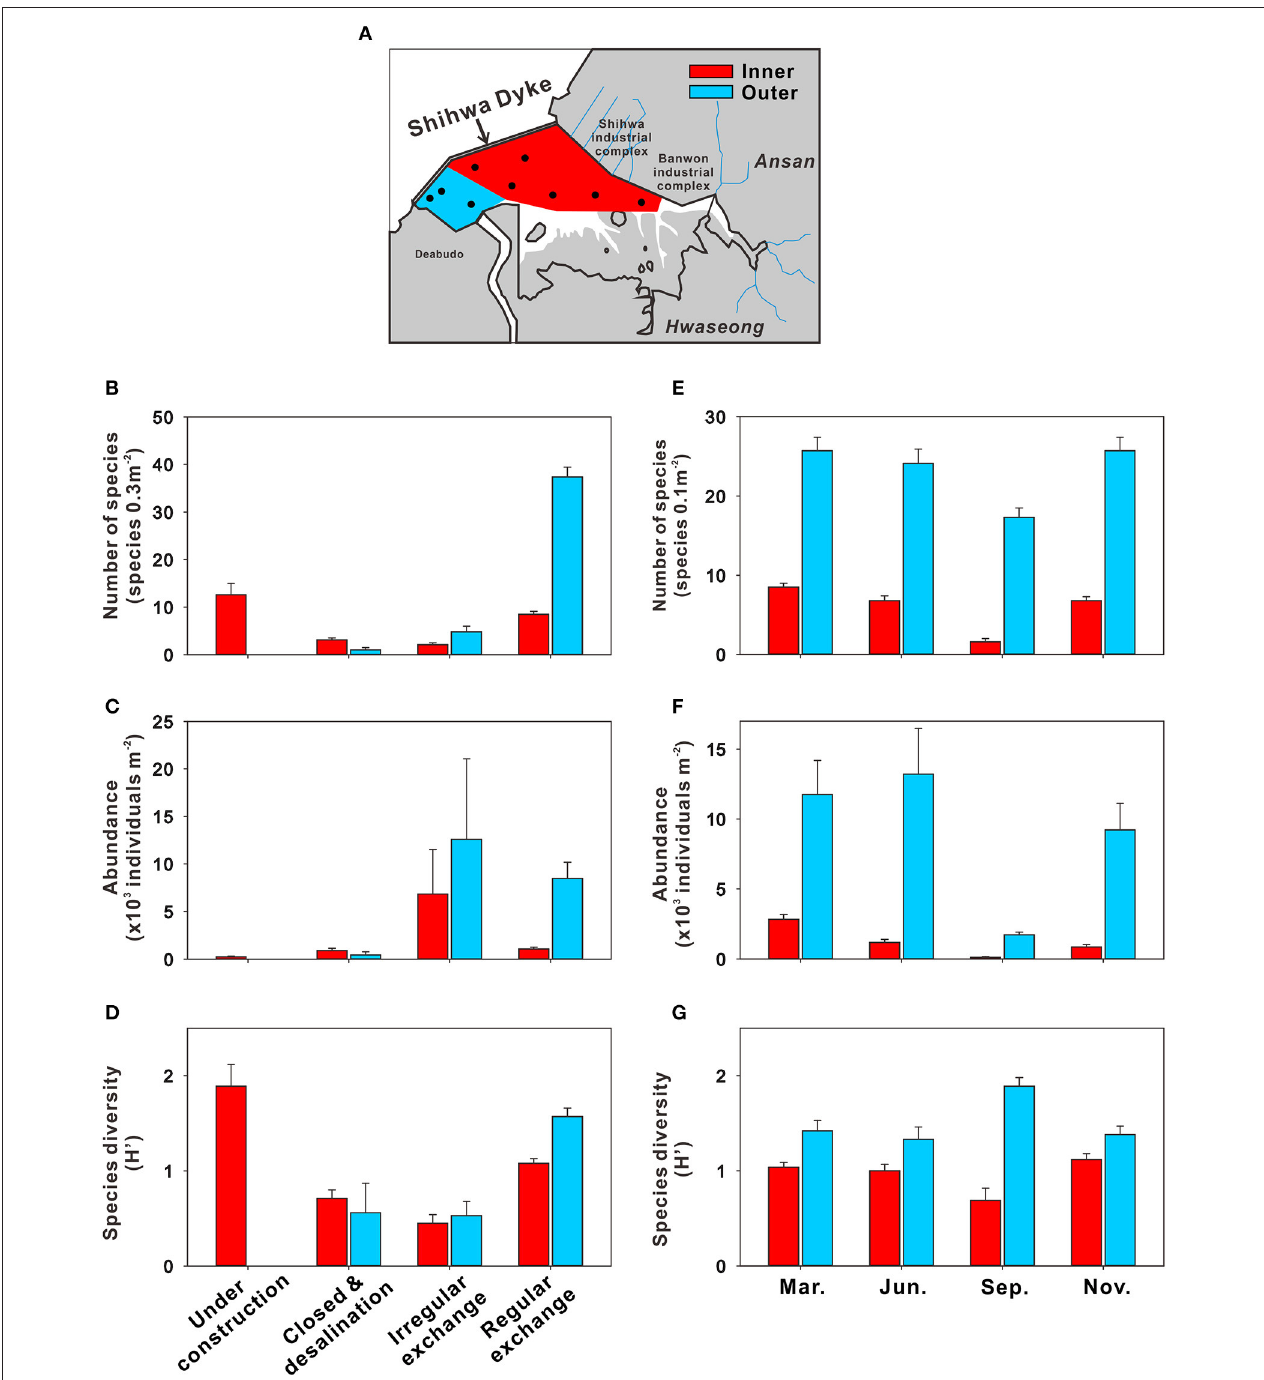
FIGURE 9 | Benthic community changes in Shihwa Bay (SB) before and after construction of a dyke. (A) A map showing the benthic sampling sites in SB (red, inner area; blue, outer area). Variation in (B) the mean number of species (species 0.3 m − 2 ), (C) mean abundance ( × 10 3 individuals m − 2 ), and (D) mean diversity (Shannon diversity index) according to the history of dyke construction. Seasonal variation in (E) the mean number of species (species 0.1 m − 2 ), (F) mean abundance ( × 10 3 individual m − 2 ), and (G) mean diversity for the period of 2000–2003. The bars indicate standard errors. The data source is Hwang (2008).